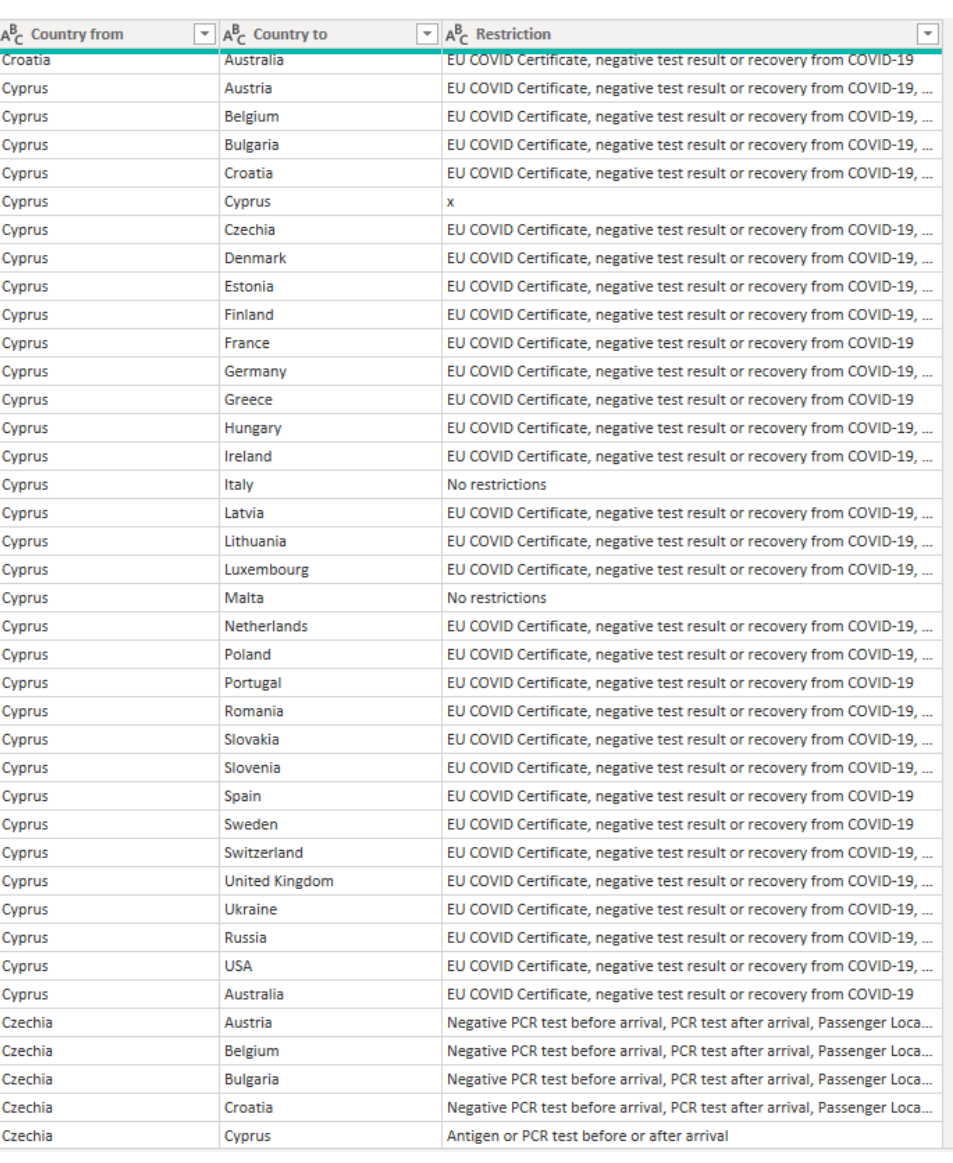
Figure 4. Part of the transformed table from the Power BI view . Source: Authors own elaboration.